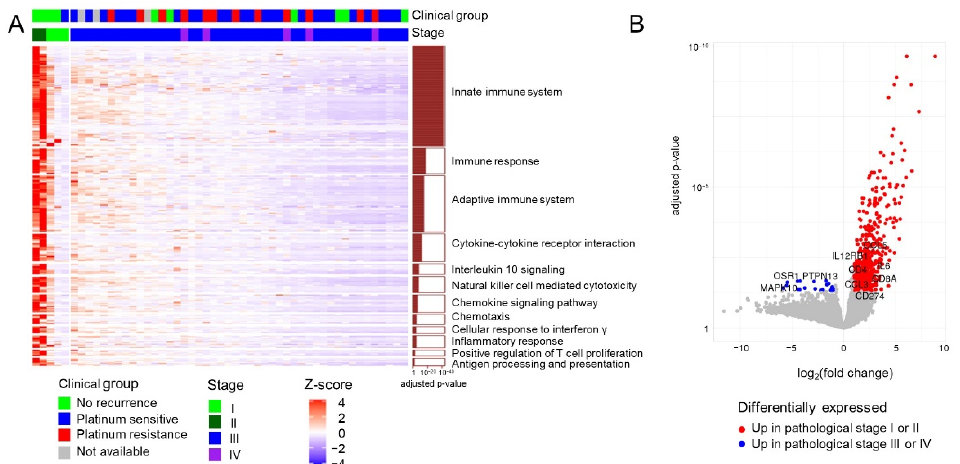
Figure 1. Transcriptome profiles of 51 patients with HGSC. ( A ) Heatmap of upregulated genes in patients with early-stage HGSC. The significant enrichment of individual pathways among the differentially expressed genes is depicted as a bar plot on the right. ( B ) Volcano plot depicting differentially expressed genes between different stage groups (I or II vs. III or IV).